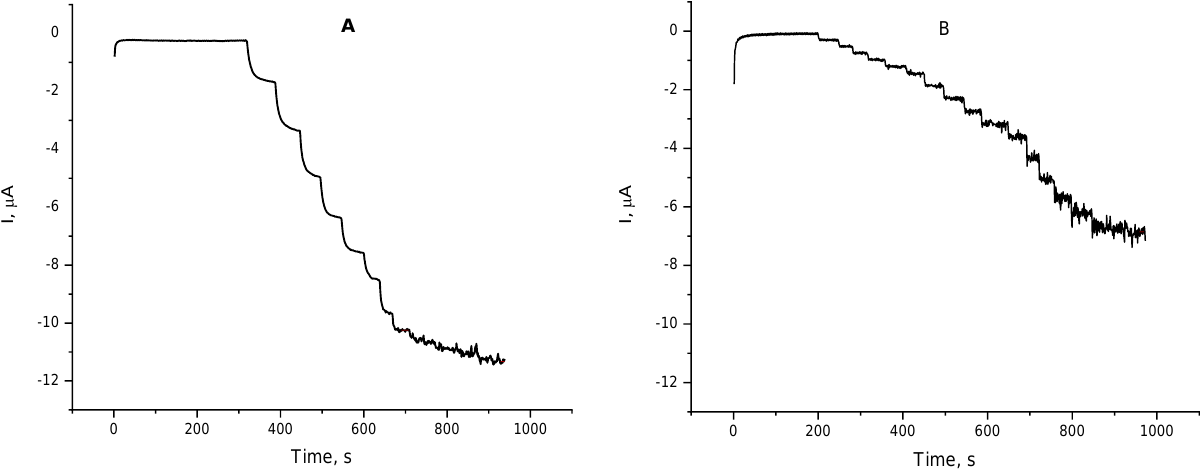
Figure 6. Chronoamperometric records of the laccase biosensor response to the addition of aliquots of dopamine ( A ) and L-epinephrine ( B ) stock solution (10 mM in citrate buffer pH = 4.0); electrolyte— 0.05 M citrate buffer with 0.1 M NaClO 4 , pH = 4.0 working potential − 0.1 V (vs. Ag|AgCl, sat. KCl); 20 ± 1 °C.